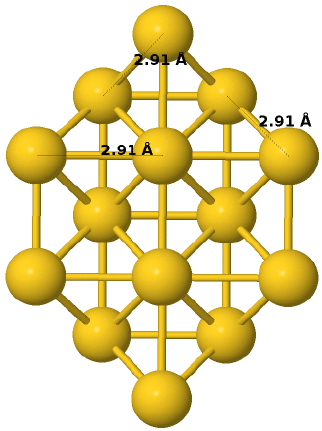
Fig. 4. Optimized geometry of an Au monolayer structure with bond length results.